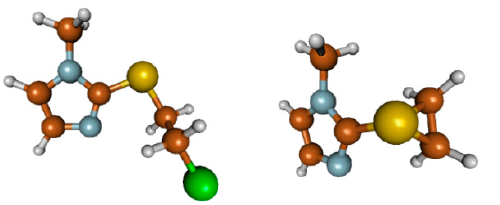
Figure 10. Optimized geometries of 3 (left) and the thiiranium cation 5 (right), obtained at the (SMD)/M06–2X/6–31+G(d) model.